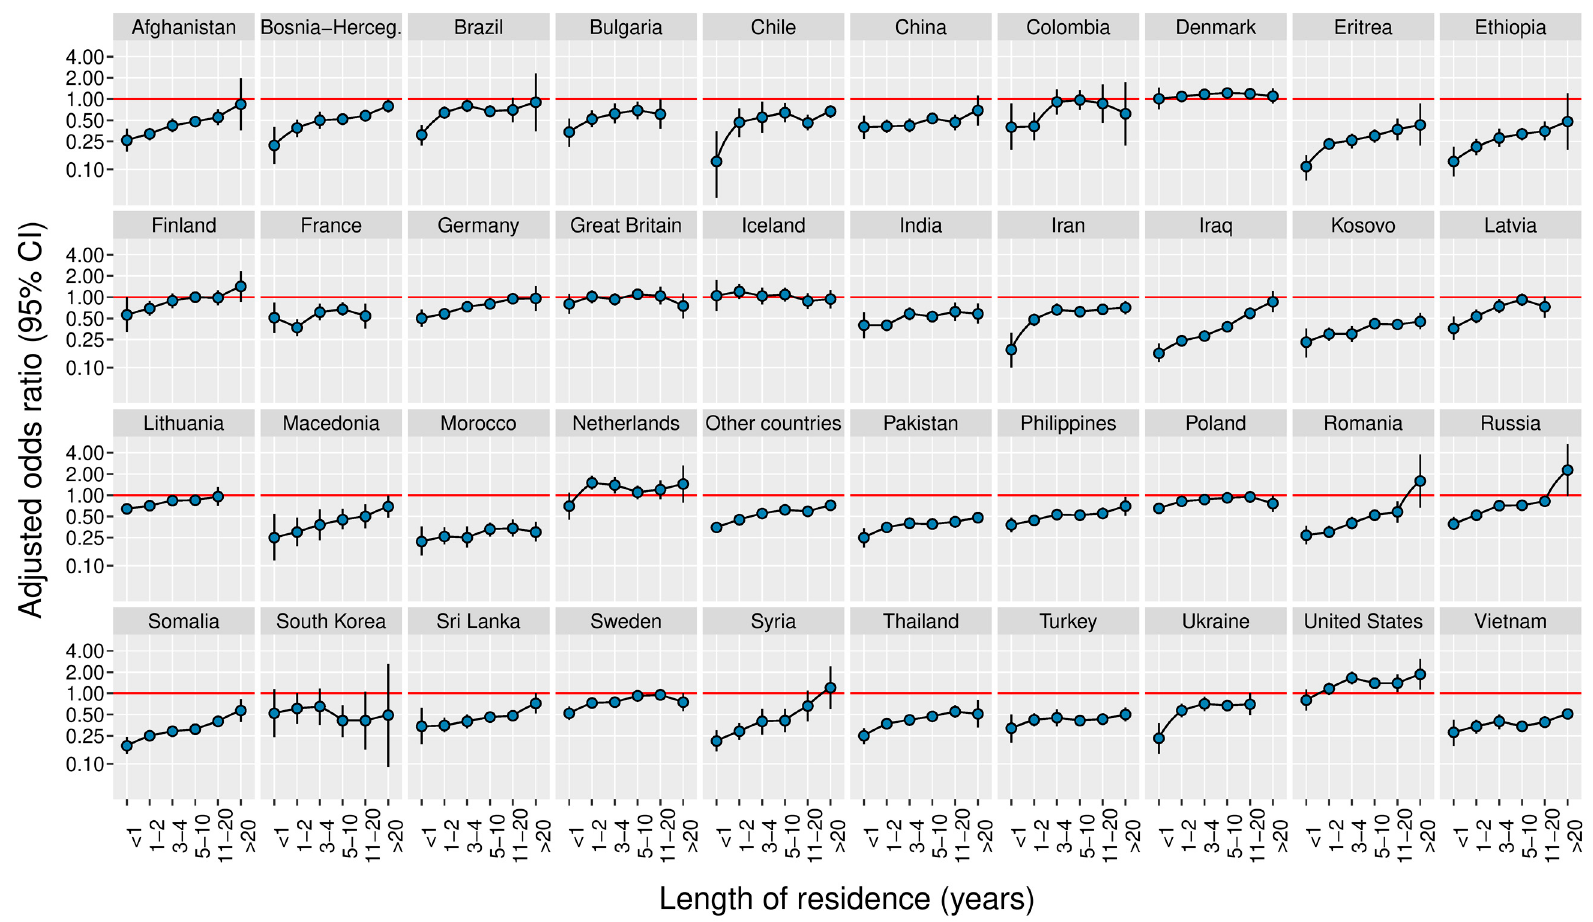
Figure 3. Adjusted odds ratios for preconception folic acid supplement use in 1st generation immigrant women by maternal length of residence and maternal country of birth (1999–2016). The reference group was Norwegian-born women with two Norwegian-born parents (non-immigrants). Odds ratios were adjusted for year of birth, maternal age, marital status, parity, geographical region, education, and income. CI indicates confidence interval.